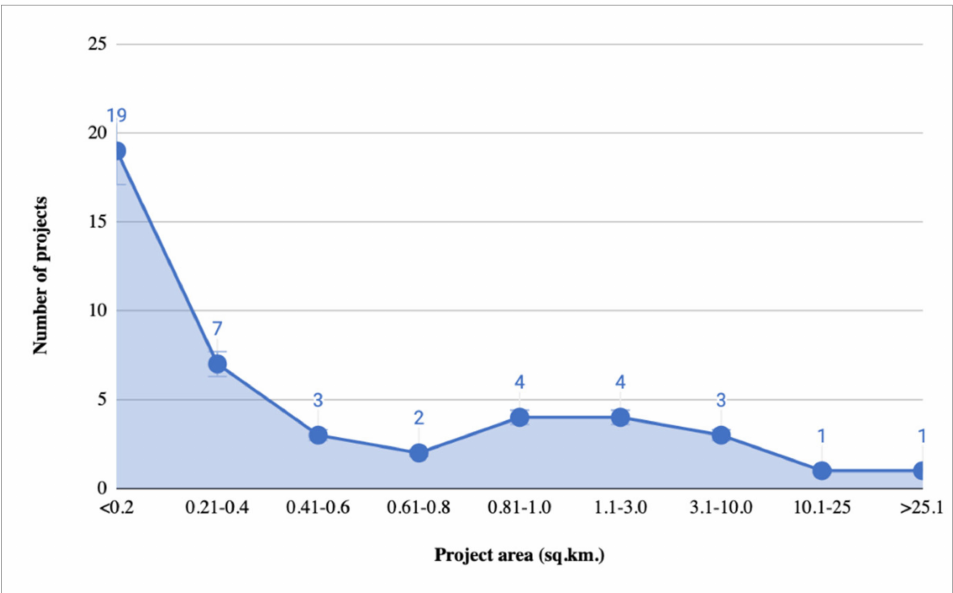
Figure 4. Project area of the 60 PED related